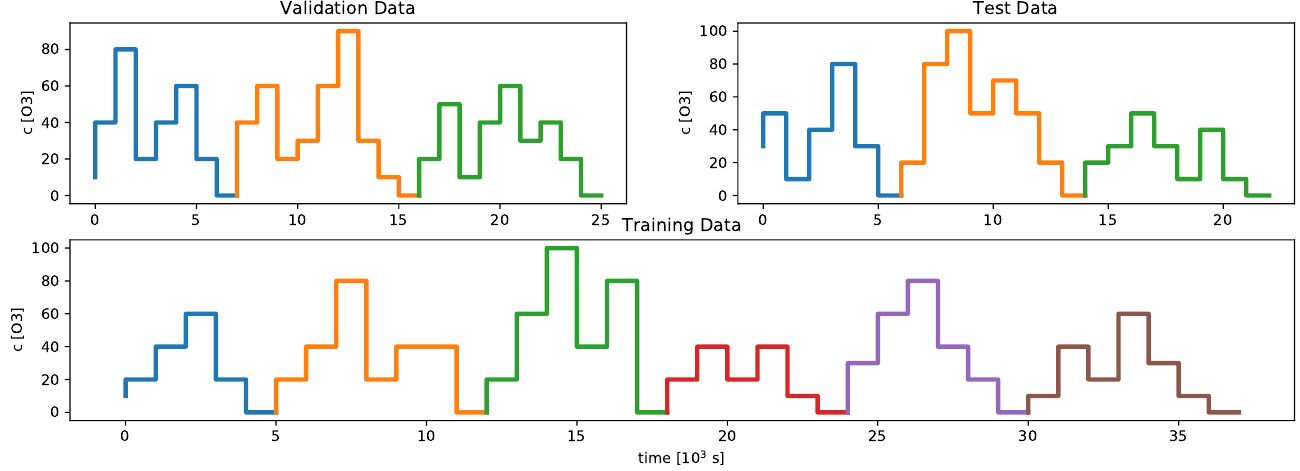
Figure 2. The figure shows the different concentration profiles used for the training, validation and test dataset. The different colors represent the subprofiles that were permuted in several simulation runs in order to augment the data and to stabilize the pattern recognition